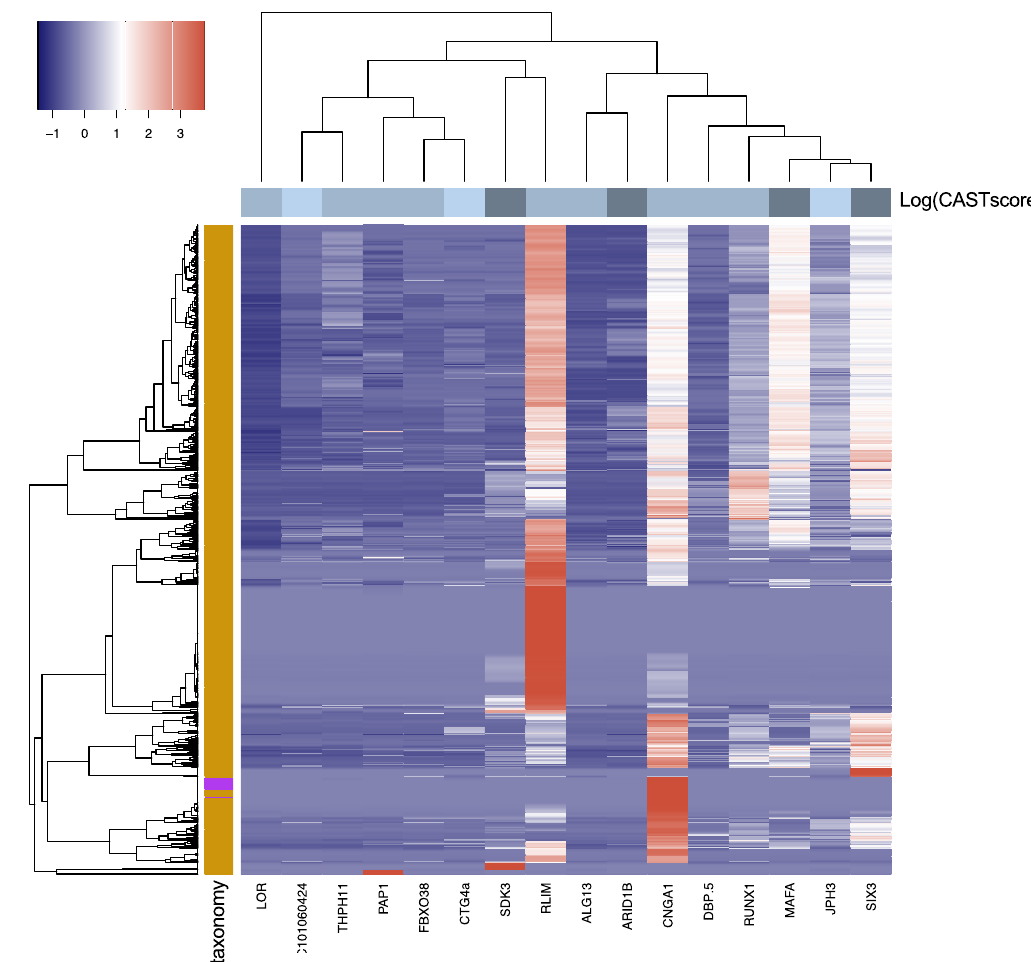
Figure 4. Phylogenetic profile of the 100-gene subset with confident disease associations. The heatmap represents the number of homologues found across species for each gene. The plotted values correspond to the normalized number of homologues (see Methods). The row side colours correspond to the log of the sum of CAST scores for all detected compositionally biased regions for each protein (darker colour indicates higher sum of CAST scores). The column side colours indicate the taxonomic level of each target proteome (orange = eukaryotes, purple = bacteria). DNAJC5 is not